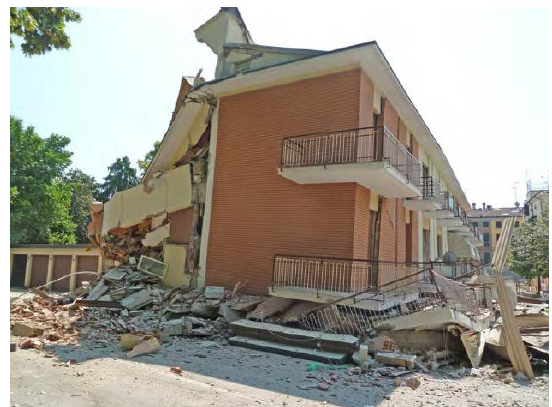
Figure 11. RC building with pilotis at the ground floor.